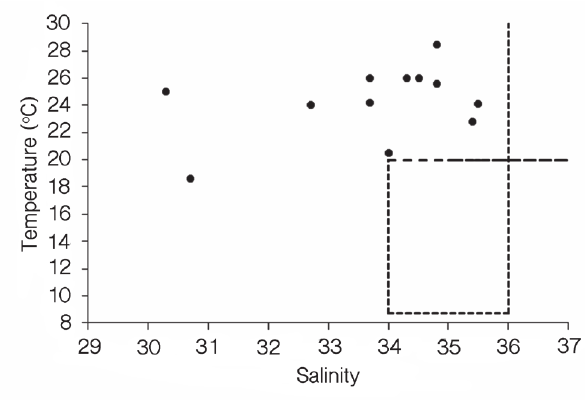
Figure 8. T-S diagram indicating the presence of water masses in the study region from May 2002 to April